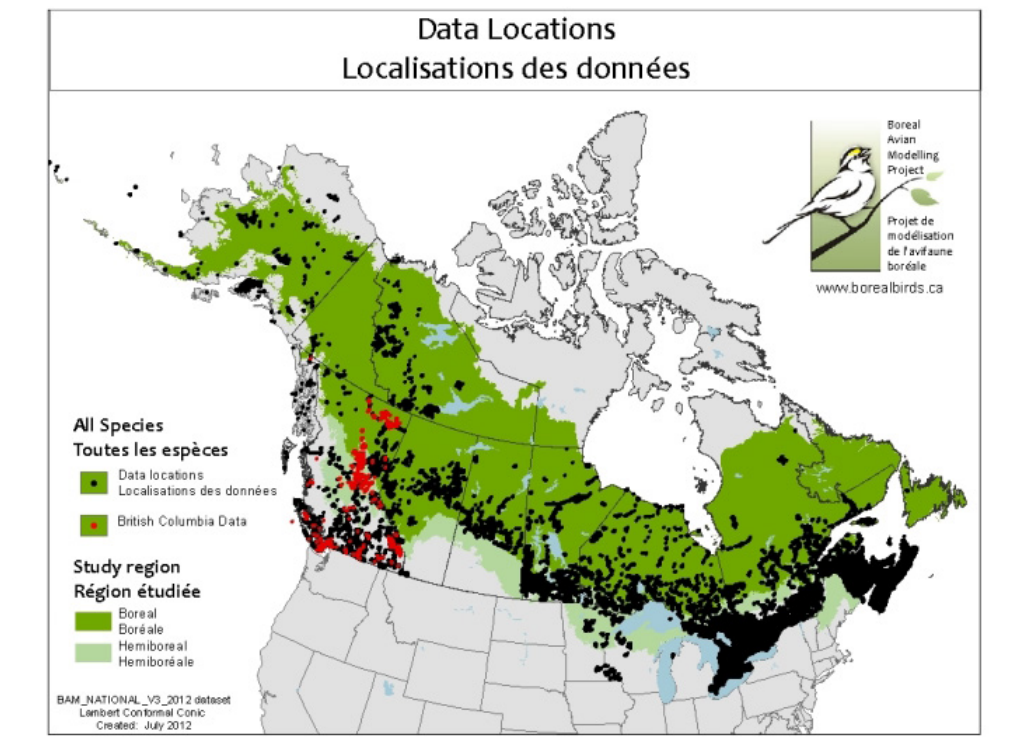
Fig. 1 . Distribution of avian point-count samples used in density estimates derived from the Boreal Avian Modeling project